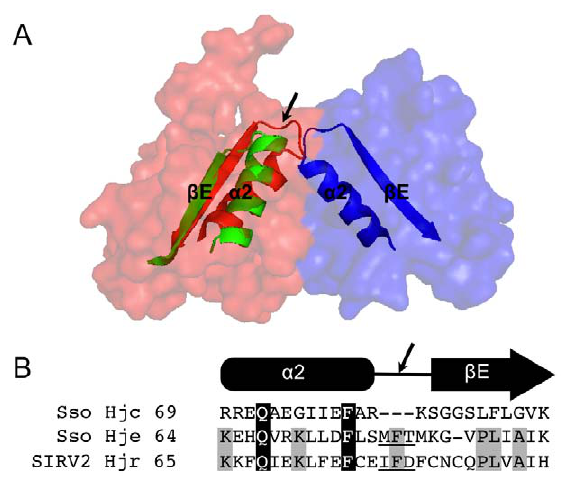
Figure 6. Structural variation at the Sso Hje and Hjc dimer interface modulates cleavage specificity. (A) Sso Hje (accession: 1OB8) and Sso Hjc (accession: 1HH1) three-dimensional structures were aligned using MacPymol. Sso Hje monomers (red and blue) are visualized by a surface view to highlight the dimer arrangement. A domain formed by helix alpha-2 and beta strand beta-E form part of the dimer interface (arrow). In insertion in the loop between helix alpha-2 and beta strand beta-E (arrow) (Sso Hje: red and blue; Sso Hjc: green) shifts dimer conformation and may confer strand cleavage specificity. (B). The amino acid sequence of the Sso Hje, Sso Hjc, and SIRV2 Hjr dimerization interface helix alpha-2 and beta strand beta-E were aligned by Clustal W and the insertion loop is underlined. Amino acids conserved between Sso Hje, Sso Hjc, and SIRV2 Hjr are shaded in black and those conserved between Sso Hje and SIRV2 Hjrare shaded in